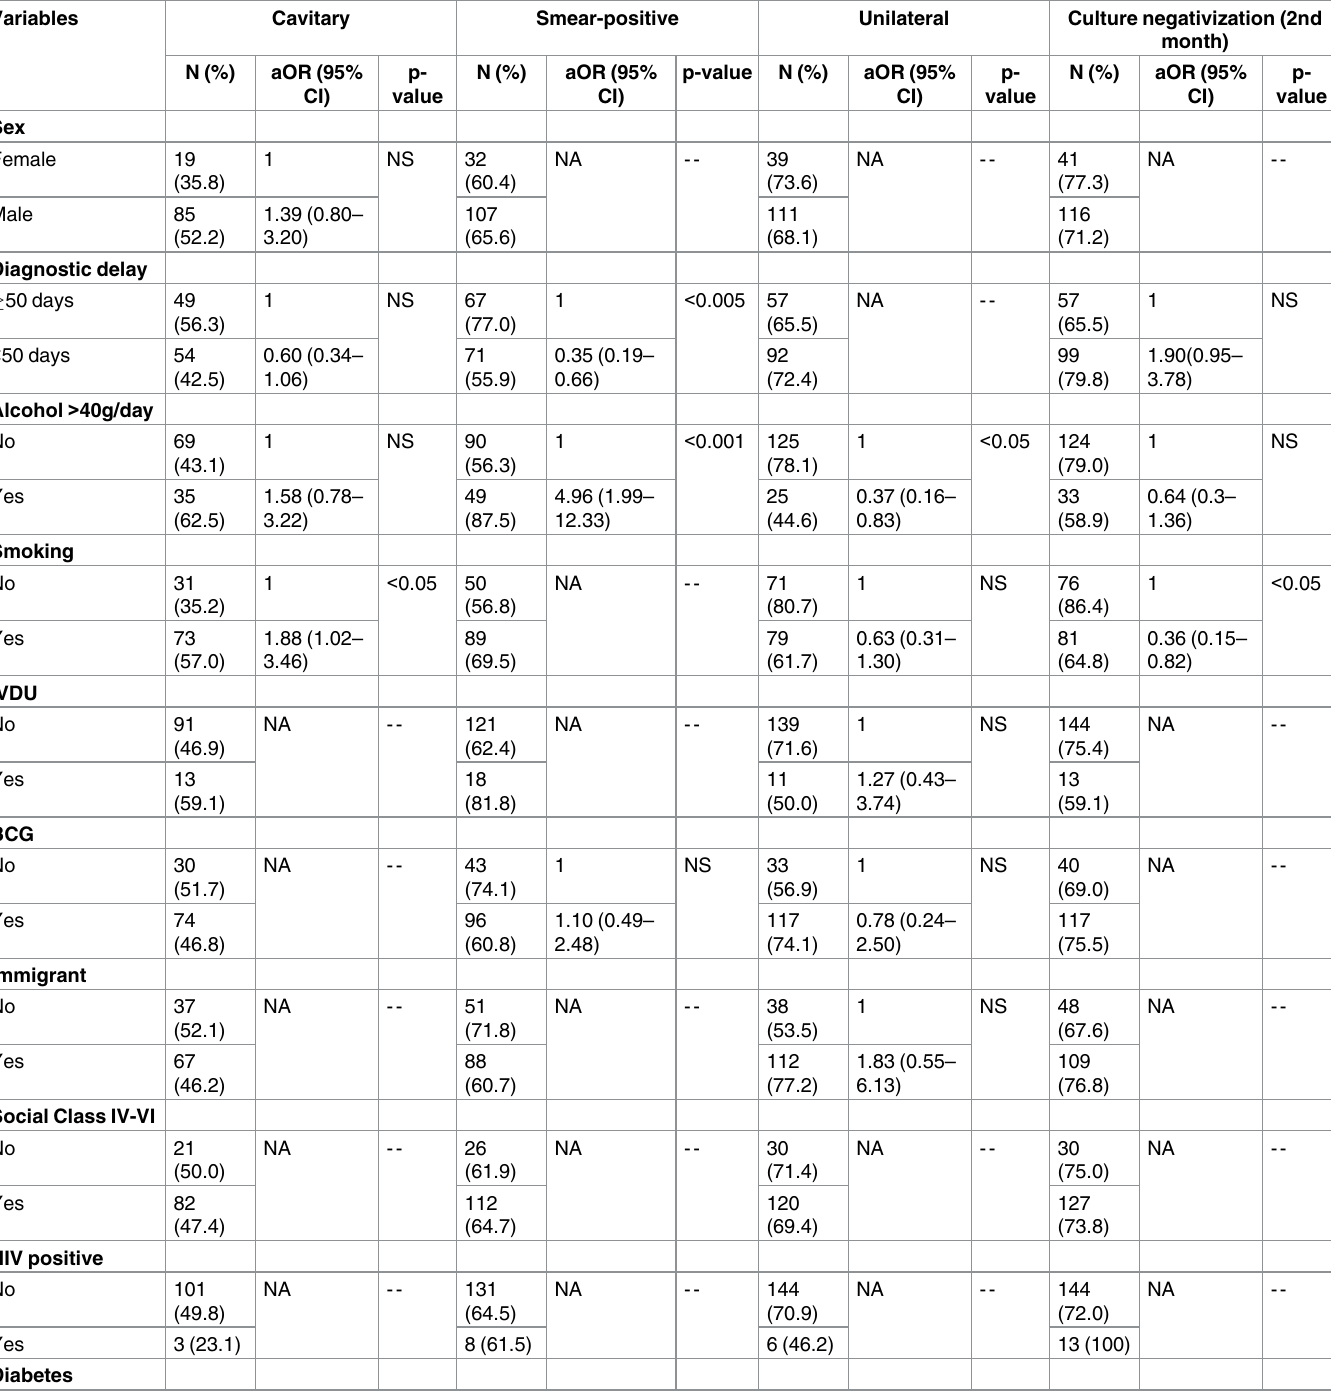
Table 3. Associations between different TB risk factors and clinical characteristics of the disease. A multivariate analysisand an aOR has been per- formed consideringstatistically significantvariablesobservedin the bivariate analysis.